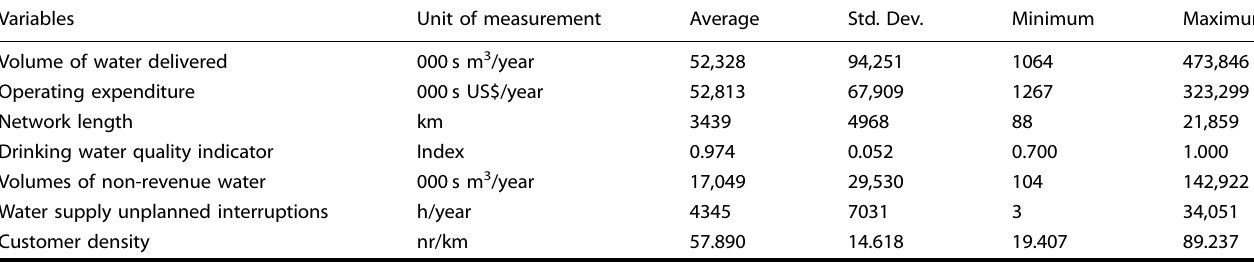
Table 2. Descriptive statistics of the Chilean water companies for 2010 –